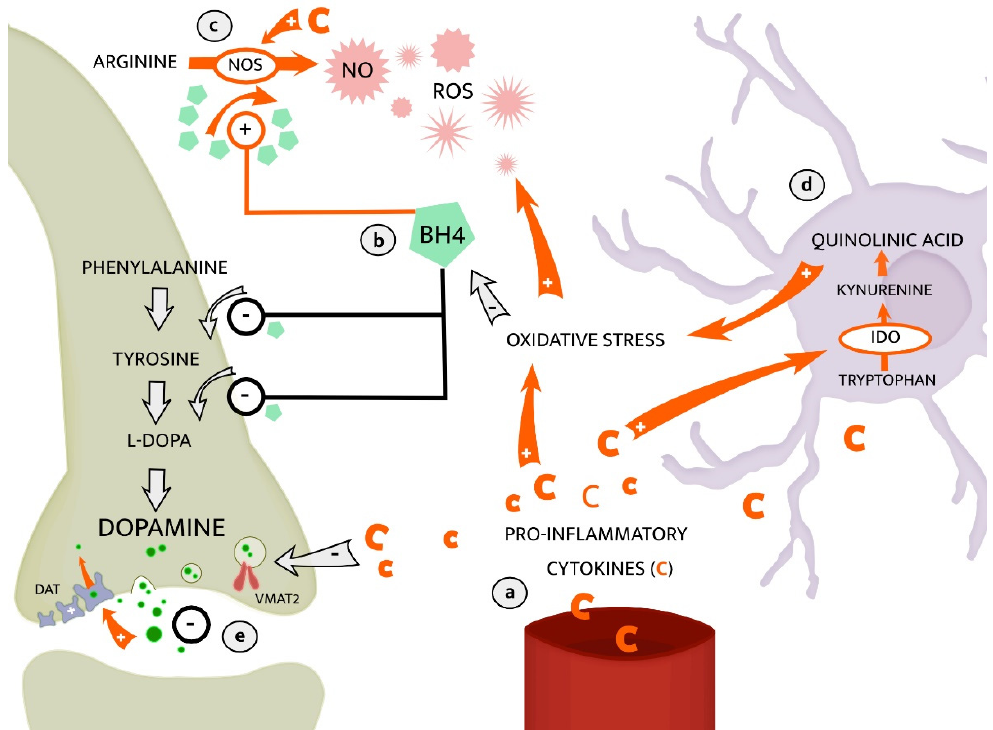
Figure 5. Crosstalk between the immune and dopaminergic systems. A pro-inflammatory state is triggered by cytokines produced by microglia or entering the central nervous system (CNS) from the peripheral circulation ( a ). Cytokine-actions with increased oxidative stress through formation of ROS may reduce part of the BH4 pool, resulting in less availability of BH4 for dopamine synthesis ( b ). BH4 availability is further reduced when cytokines activate NOS, demanding BH4 as co-factor in production of NO, further adding to oxidative stress ( c ). To the right in the figure, the “neurotoxic” and cytokine-induced branch of kynurenine pathway is presented, which occurs in microglia ( d ). The KP-metabolite quinolinic acid has neurotoxic properties and adds to oxidative stress. Lastly, available dopamine in pre-synaptic clefts is further reduced as cytokines both decrease VMAT2’s packaging of dopamine into vesicles for release, and increase DAT expression and function for re-uptake ( e ) [67]. Abbreviations: nitric oxide synthase (NOS), nitric oxide (NO), reactive oxygen species (ROS), tetrahydrobiopterin (BH4), indoleamine 2,3-dioxygenase (IDO), vesicular monoamine transporter 2 (VMAT2), dopamine transporter